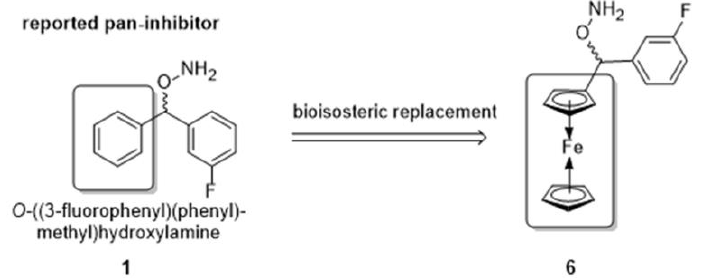
Figure 1. Bioisosteric replacement of a phenyl group with ferrocenyl moiety on a known KP pan- inhibitor.